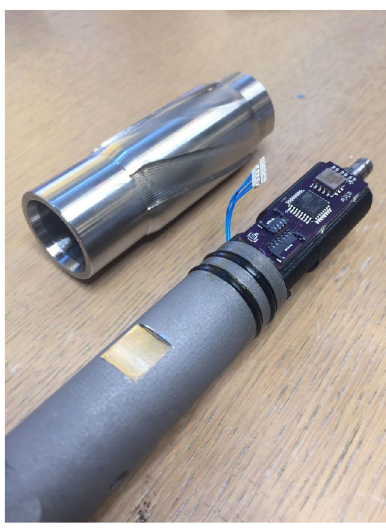
Fig. 3 Downhole sensors in the